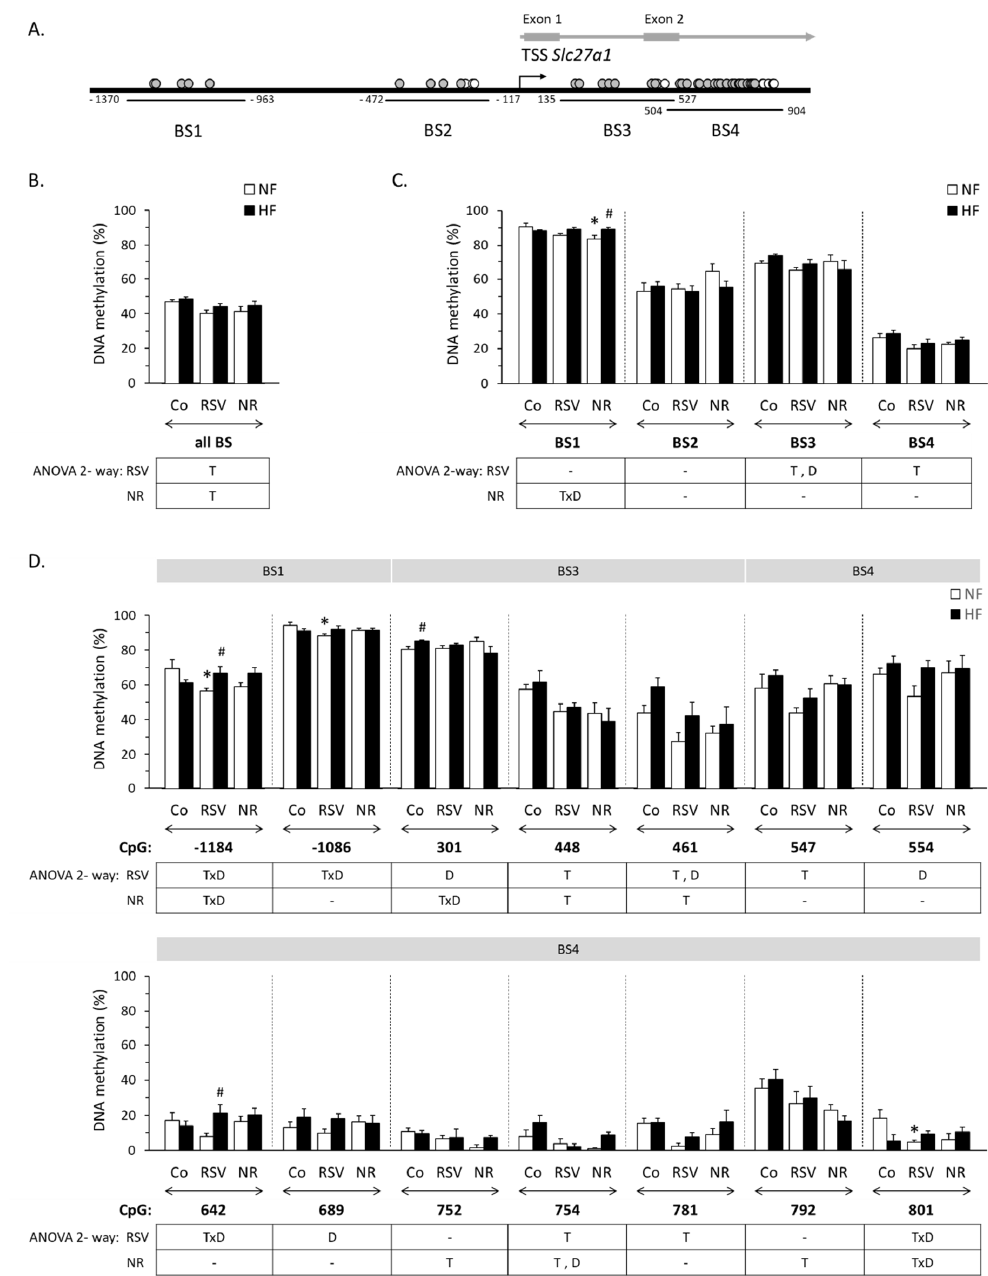
Figure 1. ( A ): Localization of the analyzed bisulfite-sequencing regions (BS) upstream and downstream the mouse Slc27a1 gene transcription start site (TSS, +1). Filled circles represent individual CpG sites whose methylation status could be successfully analyzed; empty circles represent CpG sites that could not be analyzed. ( B , C ): Mean methylation degree in all four Slc27a1 BS regions ( B ) and per BS region ( C ) in inguinal WAT of male mice neonatally treated with resveratrol (RSV) or nicotinamide riboside (NR) and submitted in adulthood to a HF/NF (high-fat/normal-fat) challenge, and corresponding control mice (Co, vehicle-treated). ( D ): Mean methylation degree in the individual CpG sites in Slc27a1 BS1 to BS4 regions (as indicated) for which there were significant changes in methylation degree in response to the neonatal treatments, the type of diet or their interaction according to ANOVA 2-way analysis; other individual CpG sites analyzed are not represented. Data: mean ± SEM of 5-6 animals per group. Statistics ( p < 0.05): T treatment, D diet, TxD treatment x diet interaction (ANOVA 2-way); * RSV or NR vs. control, # HF vs. NF ( t